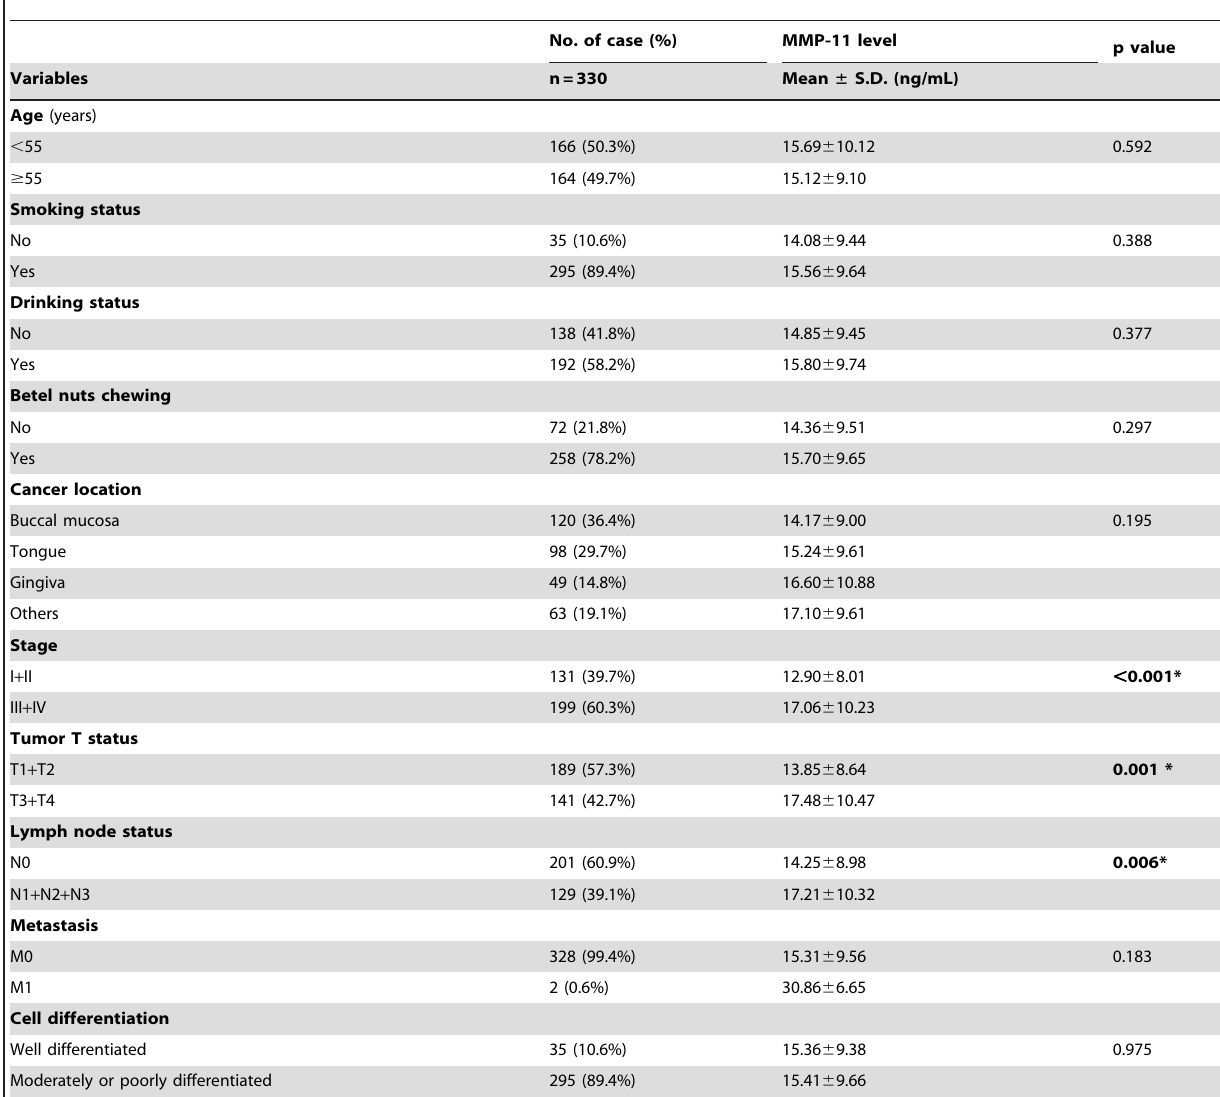
Table 2. Correlation between plasma levels of MMP-11 and clinicopathological parameters in 330 OSCC